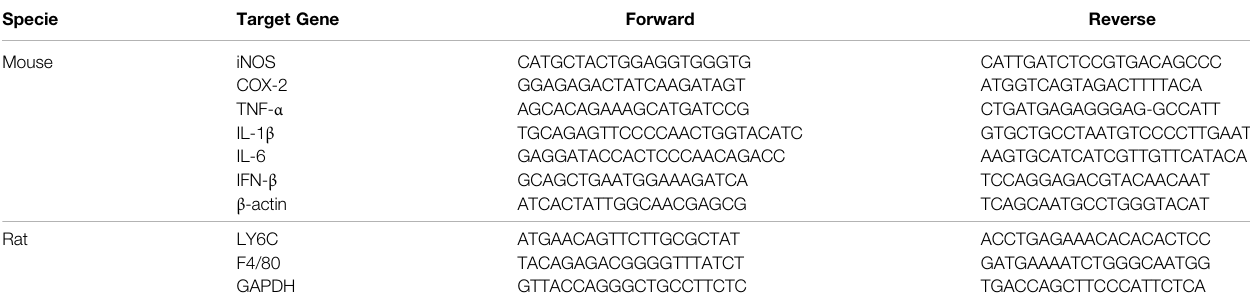
TABLE 1 | The list of primer sequence for